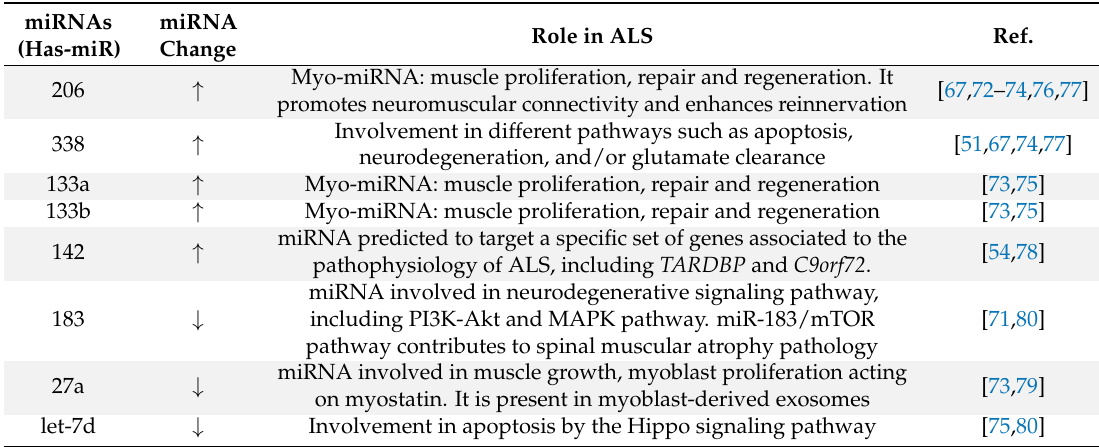
Table 3. The most promising circulating microRNAs (miRNAs) detected as potential biomarkers in amyotrophic lateral sclerosis (ALS)